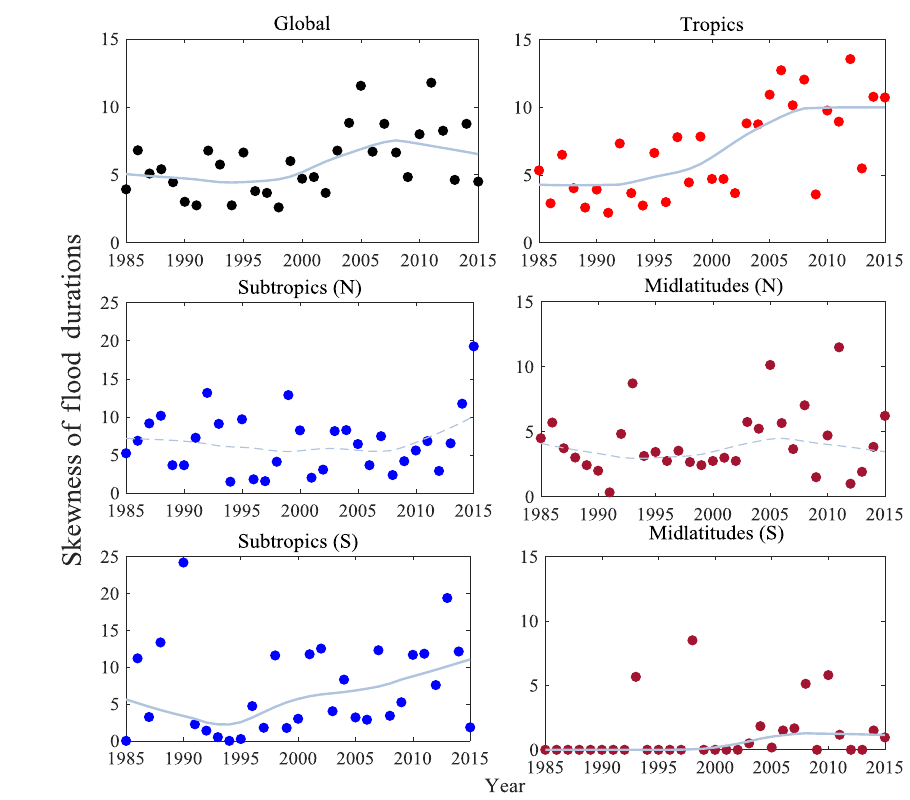
Figure 5. Same as Fig. 2 but for the resistant skewness of flood durations.